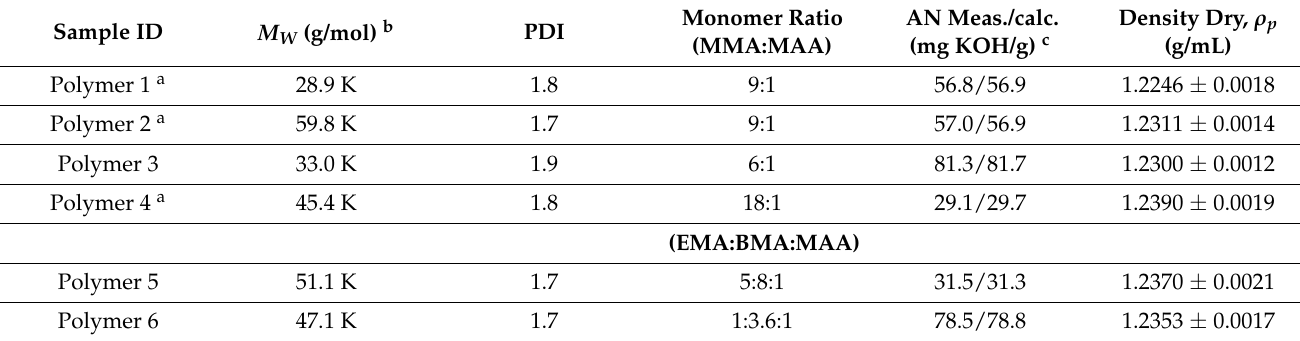
Table 2. Acid number, densities, molecular weight and polydispersity index (PDI) of the